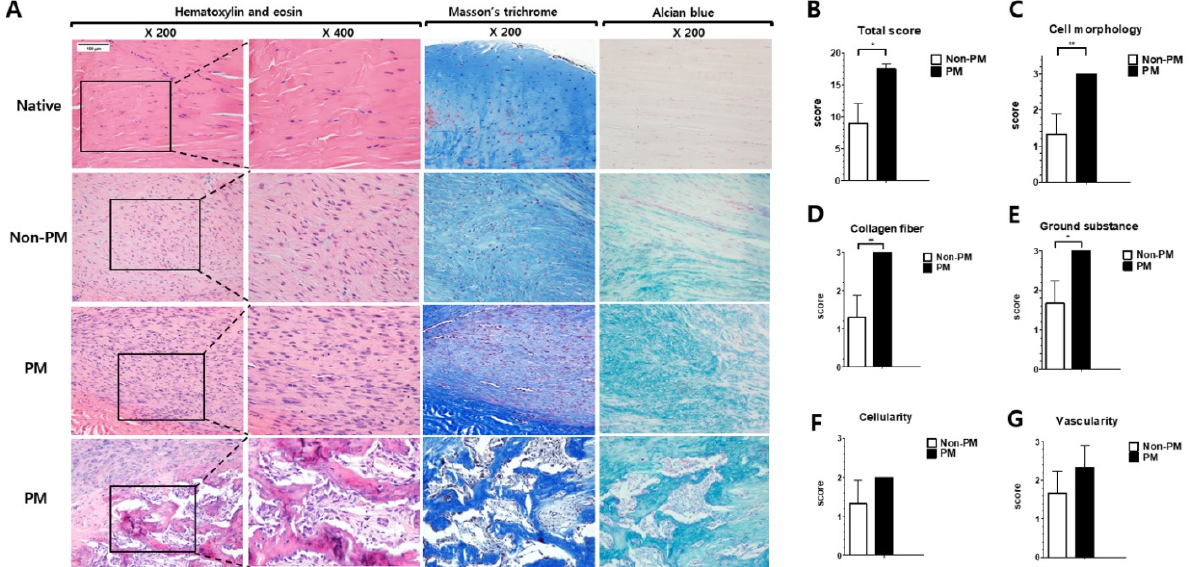
Figure 2. ( A ) Microscopic images of the Achilles tendons from native, control (non-PM), and PM-exposed rats 6 weeks post-operation. Additional images showing ossification (chondroid metaplasia in the marginal area and bone formation in the center) in the PM group are in the last row. Histological specimens were evaluated based on the modified Bonar score. The region with the greatest alteration in cell morphology was identified and evaluated. Images at 200 × and 400 × magnification of hematoxylin and eosin stain and 200 × magnification of Masson’s trichrome stain and Alcian blue stain. Histological results showing the ( B ) total score, ( C ) cell morphology, ( D ) collagen fiber arrangement, ( E ) ground substance, ( F ) cellularity, and ( G ) vascularity of non-PM and PM groups. Data are presented as means ± SD. * p < 0.05, ** p < 0.005.